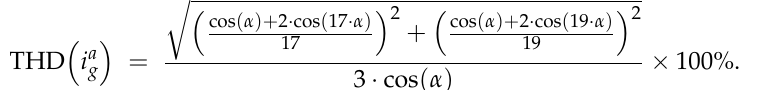
Thus, the THD expression (2) for the overall input current in the multicell AFE rectifier in phase a is given by,